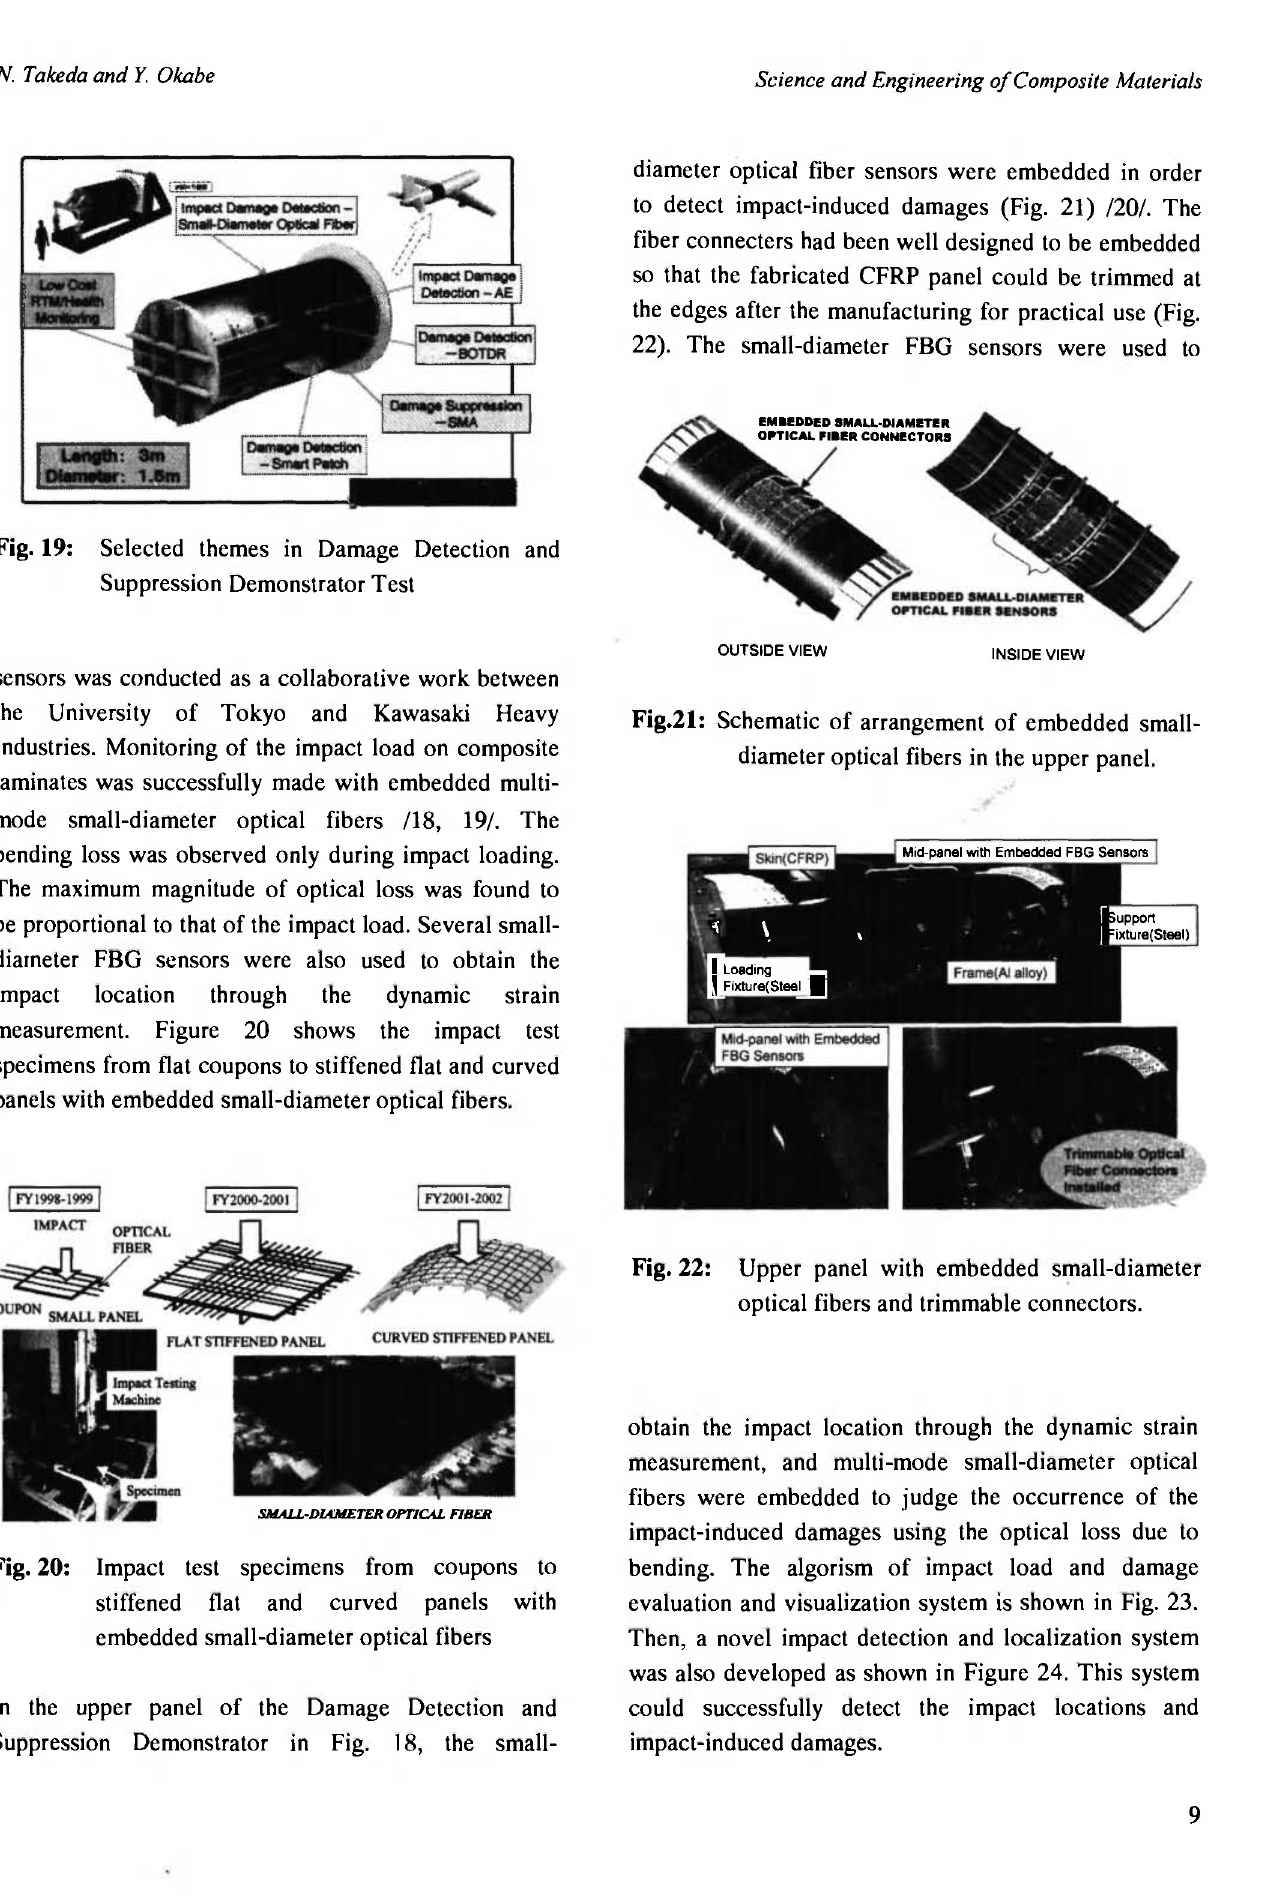
Fig. 20: Impact test specimens from coupons to stiffened flat and curved panels with embedded small-diameter optical fibers In the upper panel of the Damage Detection and Suppression Demonstrator in Fig. 18, the small-